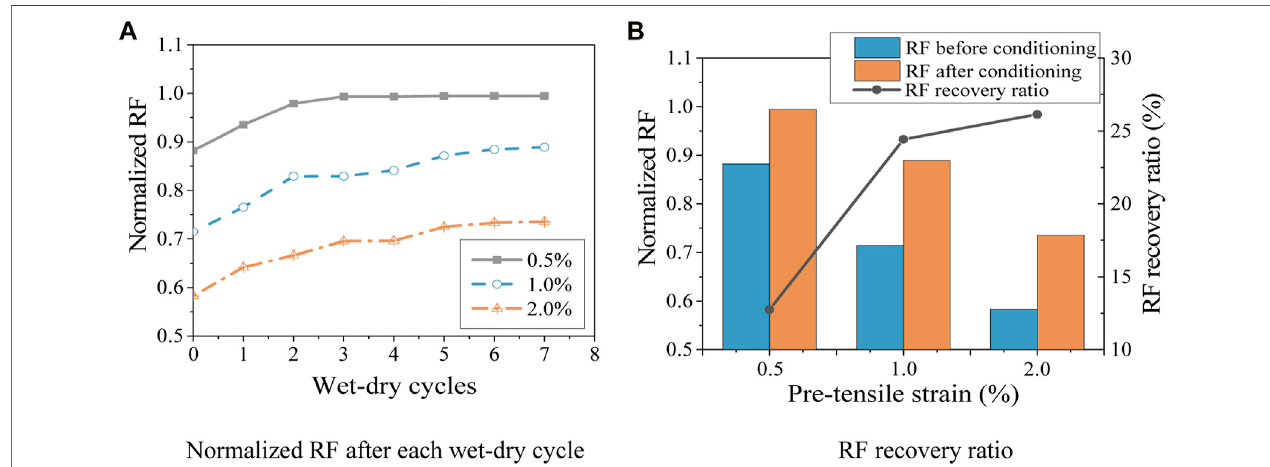
FIGURE 9 | RF of CR2-0.4 after wet – dry cycles. (A) Normalized RF after each wet – dry cycle. (B) RF recovery ratio. RF, resonant frequency.